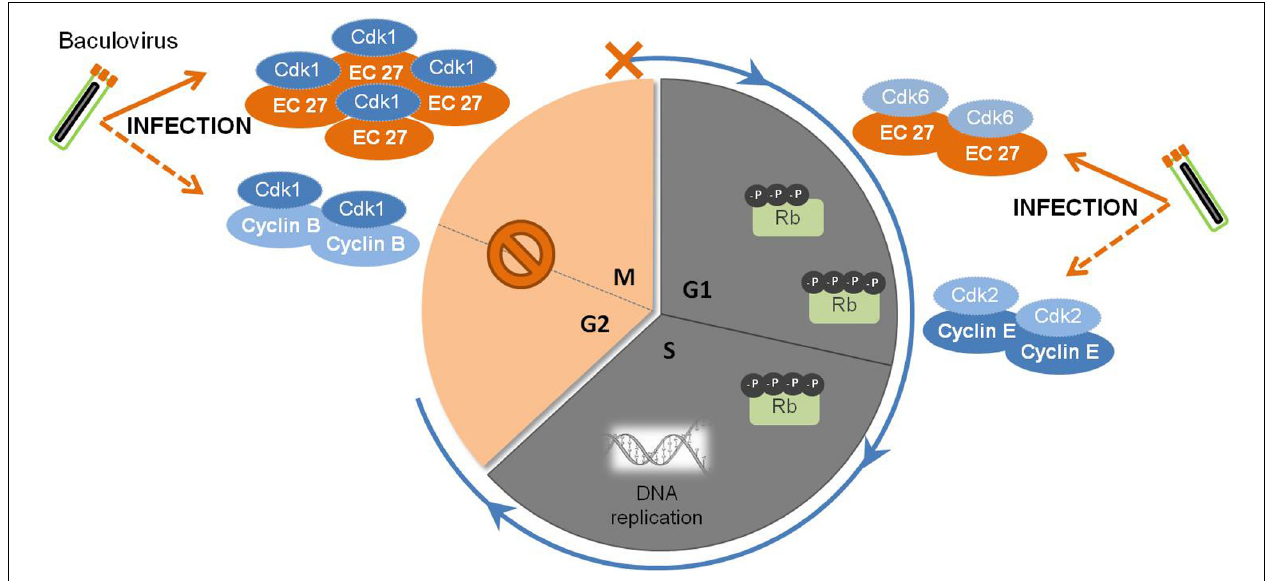
of infection. Also, EC27 can act in a cyclin D-dependent manner, forming the complex Cdk6-EC27. As a result, the retinoblastoma protein (Rb) becomes phosphorylated, together with the activation of the complex Cdk2-cyclin E. Such phenomena will trigger the components needed for DNA replication, ensuring an environment favorable for viral DNA synthesis and